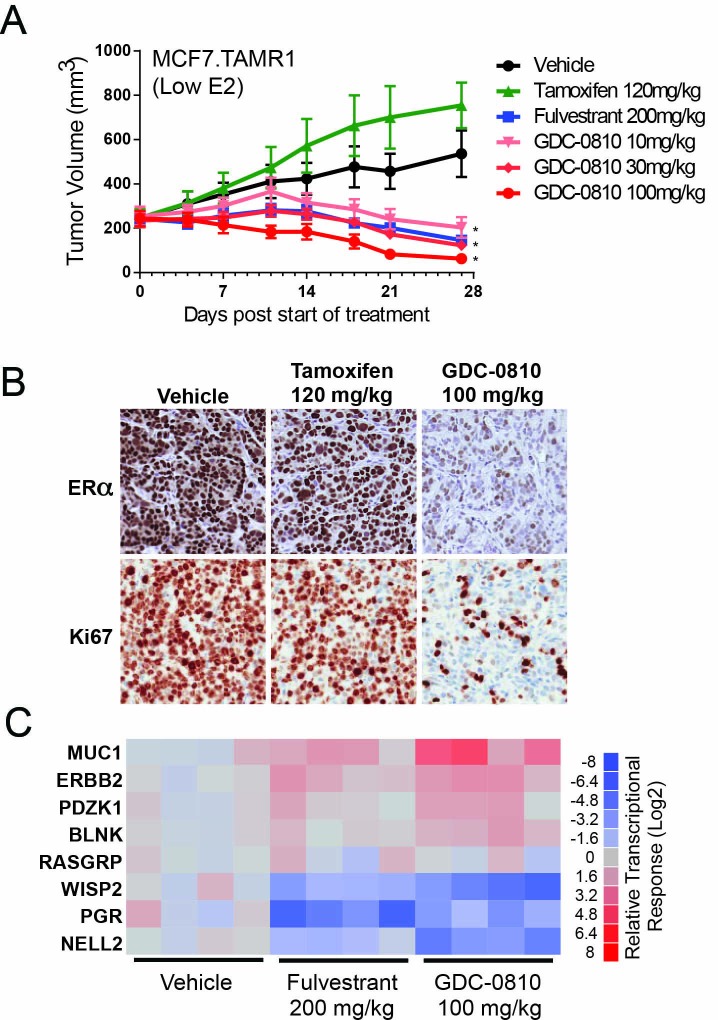
Antitumor activity of GDC-0810 in a tamoxifen-resistant breast cancer xenograft model.(A) Tamoxifen-resistant MCF7 tumors were implanted in animals supplemented with 60-day release 0.18 mg 17β-estradiol pellets. Tumor bearing animals were dosed with vehicle, tamoxifen (120 mg/kg/day p.o.), fulvestrant (200 mg/kg, 3x/week, s.c.) or GDC-0810 (10, 30 or 100 mg/kg/day, p.o.) for 27 days (B) Representative images of IHC for ERα and Ki67 in tamoxifen-resistant MCF7 xenograft tumors from (A) treated with vehicle, tamoxifen or GDC-0810. (C) Quantitative PCR analysis of ER-regulated genes in tamoxifen-resistant MCF7 xenograft tumors from (A), treated with vehicle, fulvestrant or GDC-0810. S.c. is sub-cutaneous dosing, and p.o. is per os (by mouth) oral gavage dosing. * Denotes significance (p<0.05) compared to Vehicle in 1-Way ANOVA and Dunnett's Multiple Comparison Test.